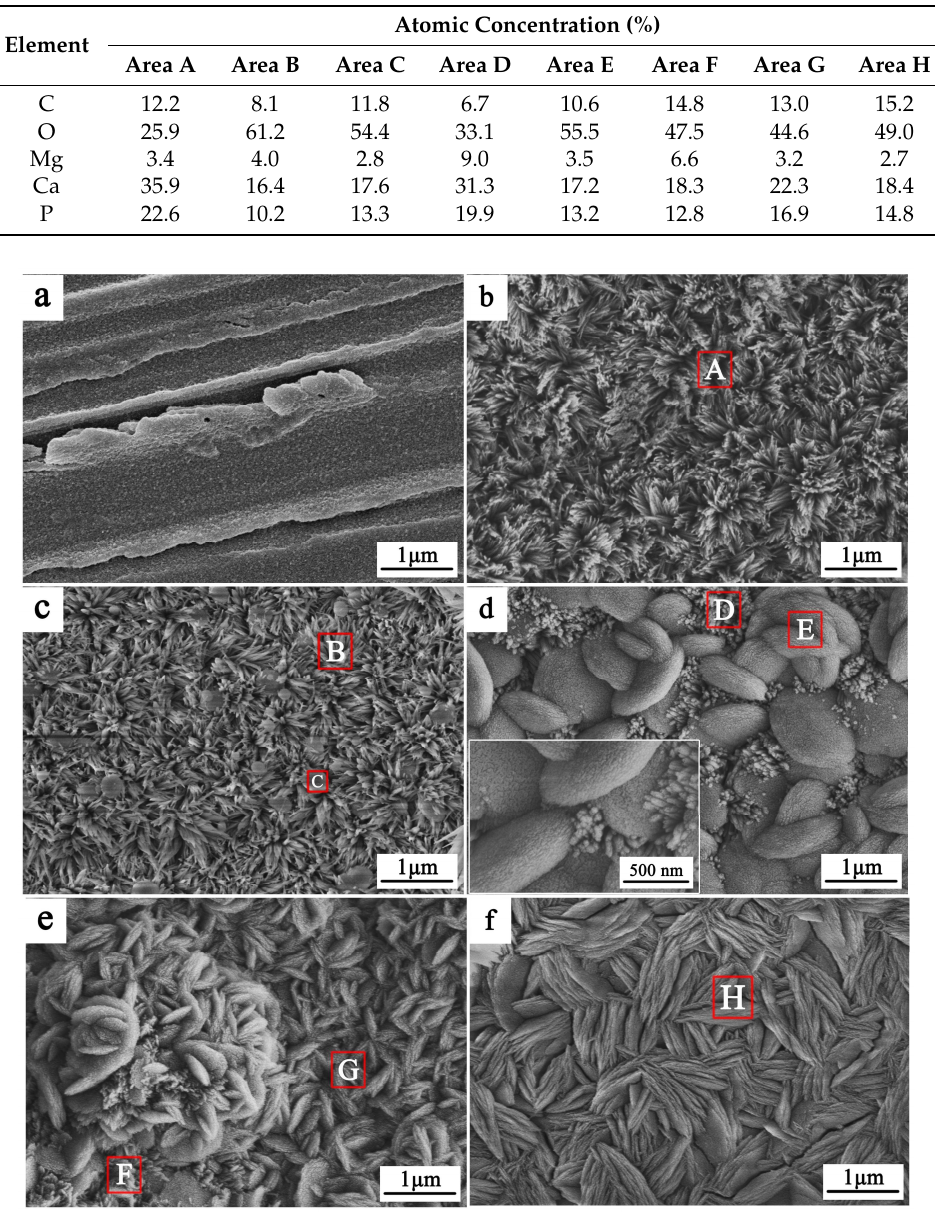
Figure 2. Surface morphologies of ( a ) naked AZ31 alloy; ( b ) CN1; ( c ) CN4; ( d ) CN7; ( e ) CN10; ( f ) CN13. Table 1. Element composition of area A, B, C, D, E, F, G and H in Figure 2.